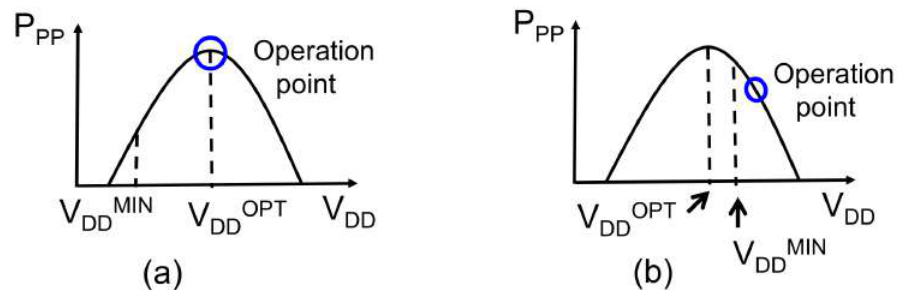
Figure 2. Operating points of [8] ( a ) and of this work ( b ).